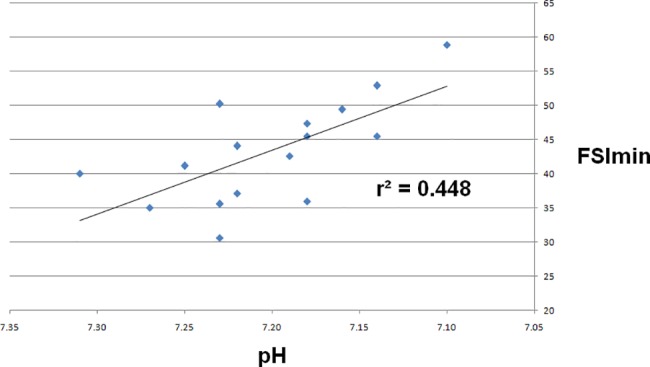
Correlation curve between FSImin and arterial pH.